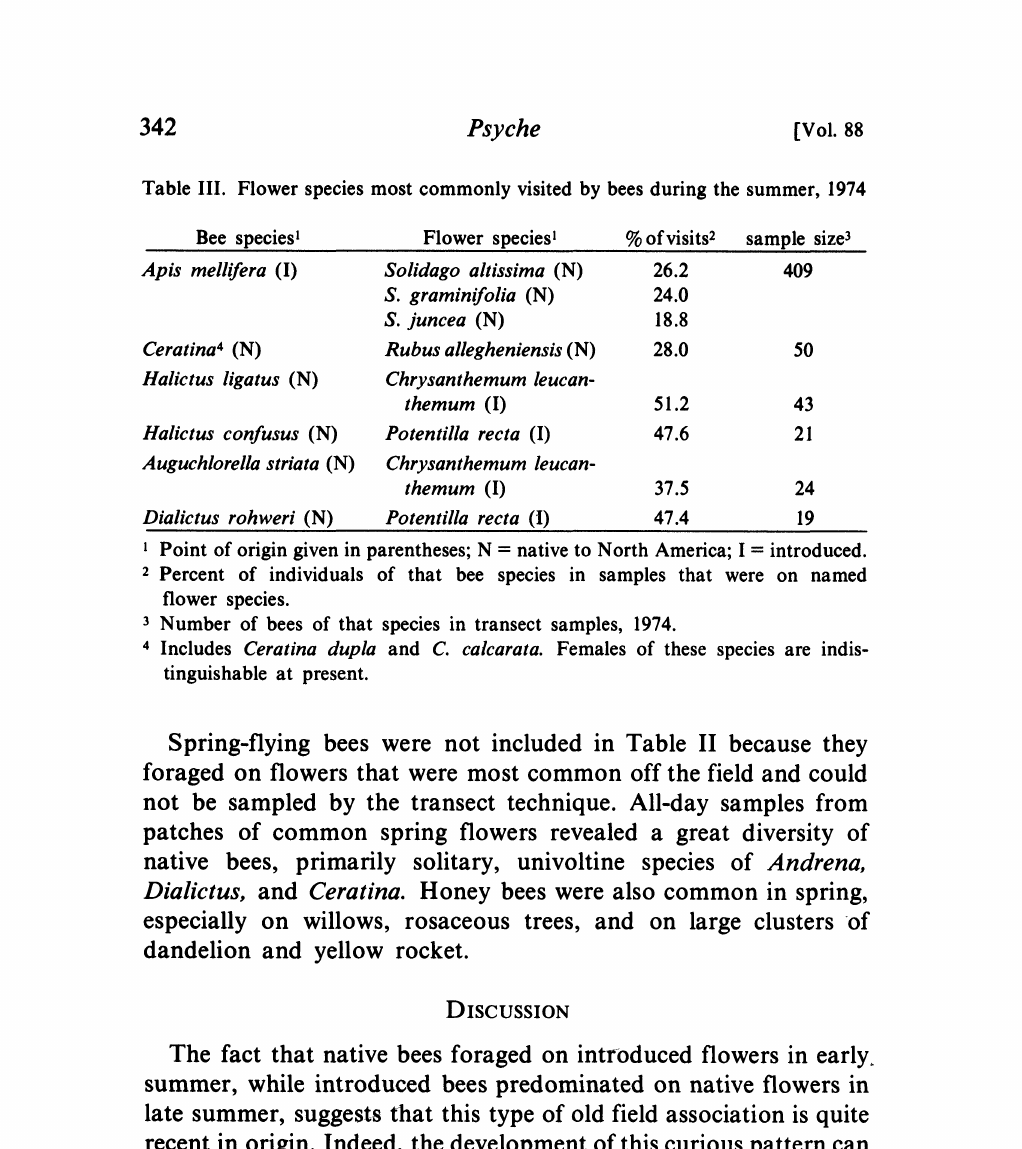
Table III. Flower species most commonly visited by bees during the summer, 1974 Bee species Flower species %of visits sample